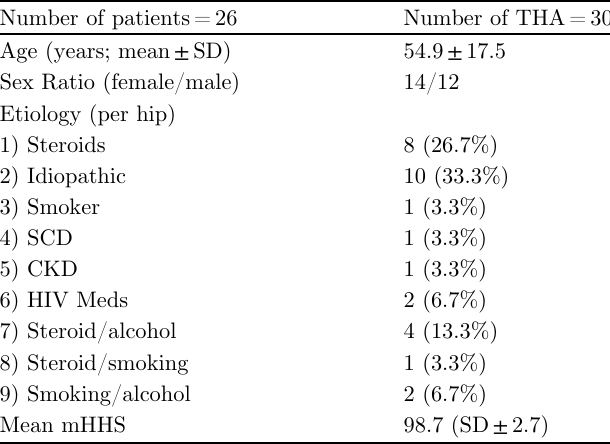
Table 1. Characteristics of the